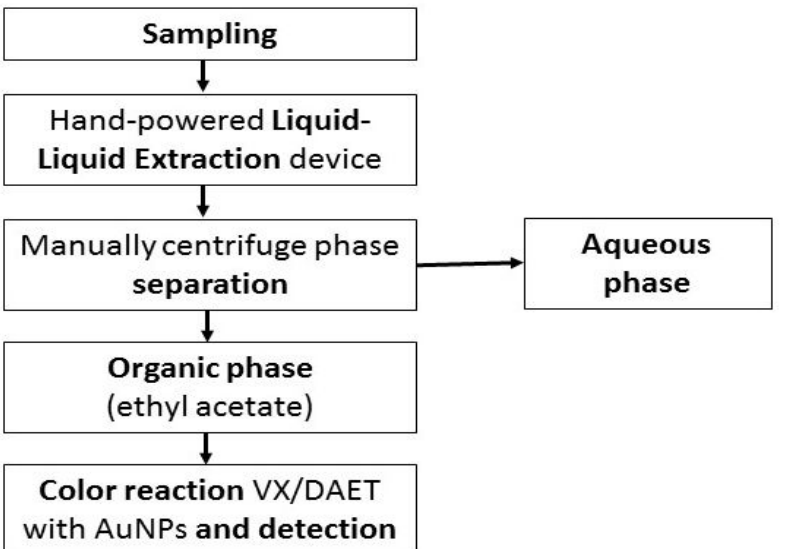
Figure 5. Scheme of colorimetric DAET/VX determination with AuNPs [19] .